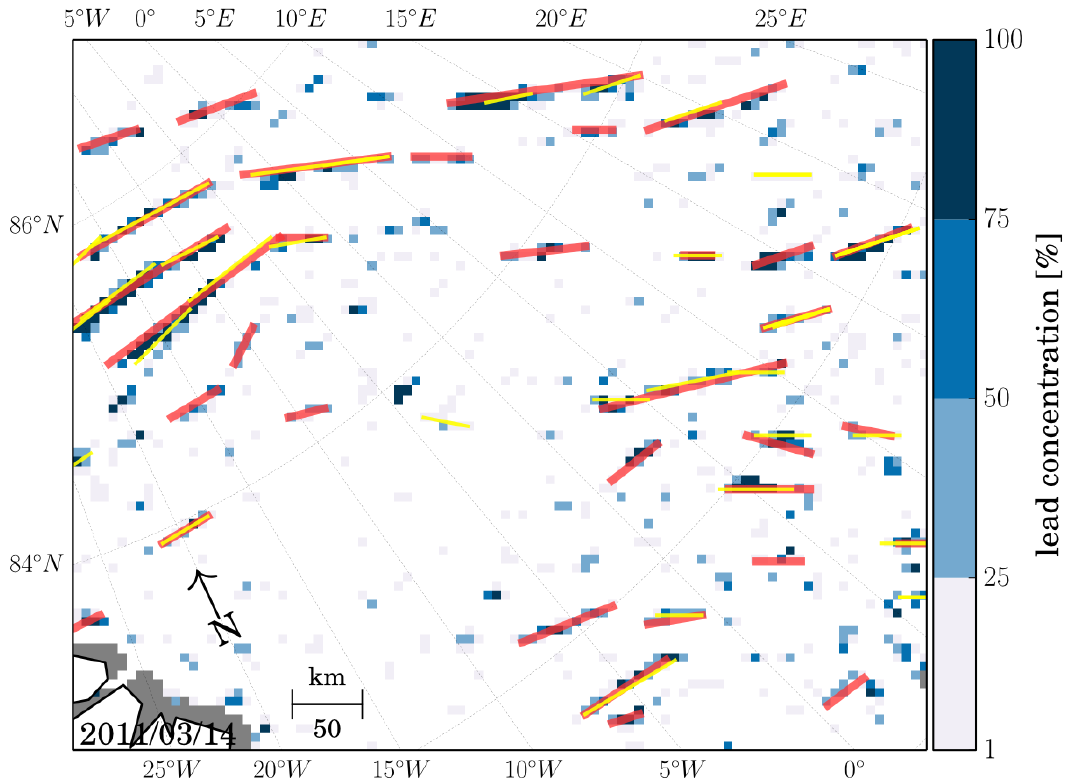
Figure 5. Comparison between reference leads (red) and clustered leads (yellow) detected by the Hough transform in the Fram Strait on 14 March